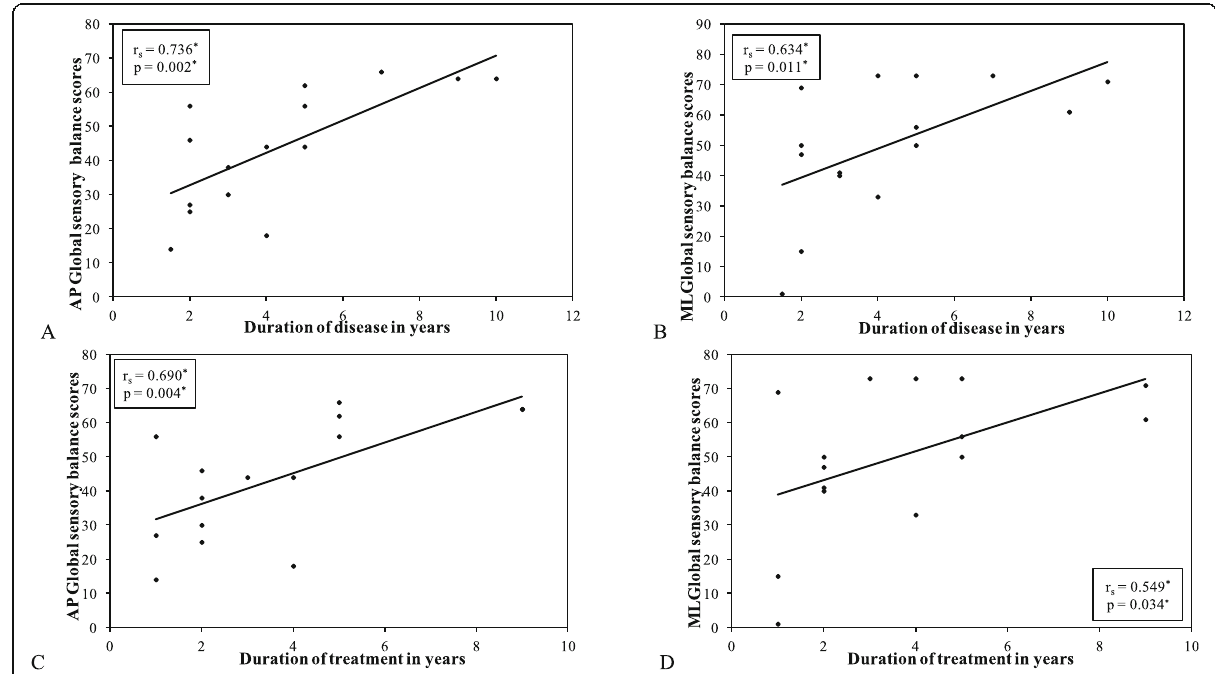
Fig. 5 Correlation of AP and ML Global sensory balance scores of the study group with durations of disease and treatment (years) ( n =